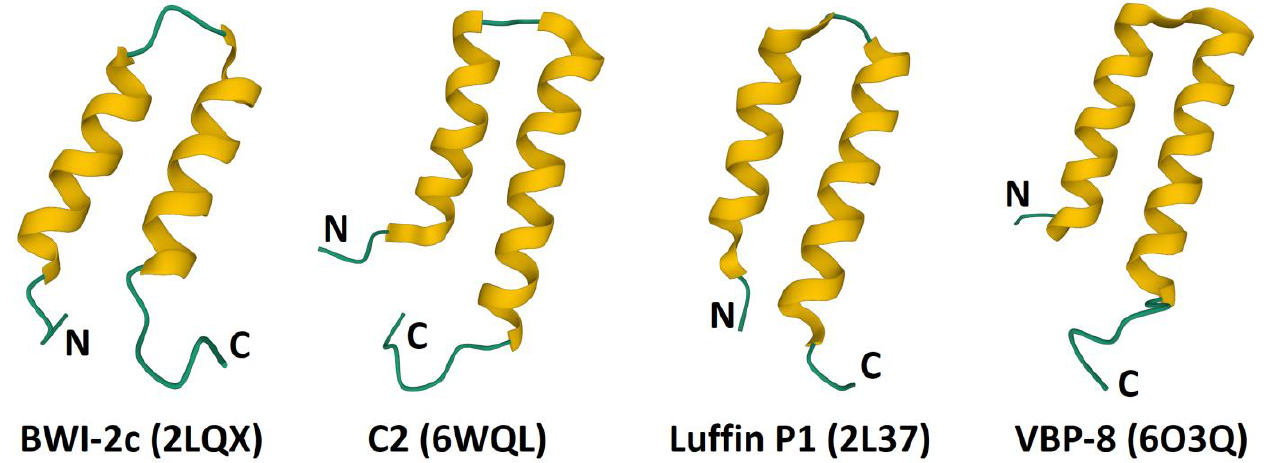
Figure 6. 3D structure of α -hairpinins. The α -helices are colored yellow. The N- and C-termini are indicated by N and C, respectively.